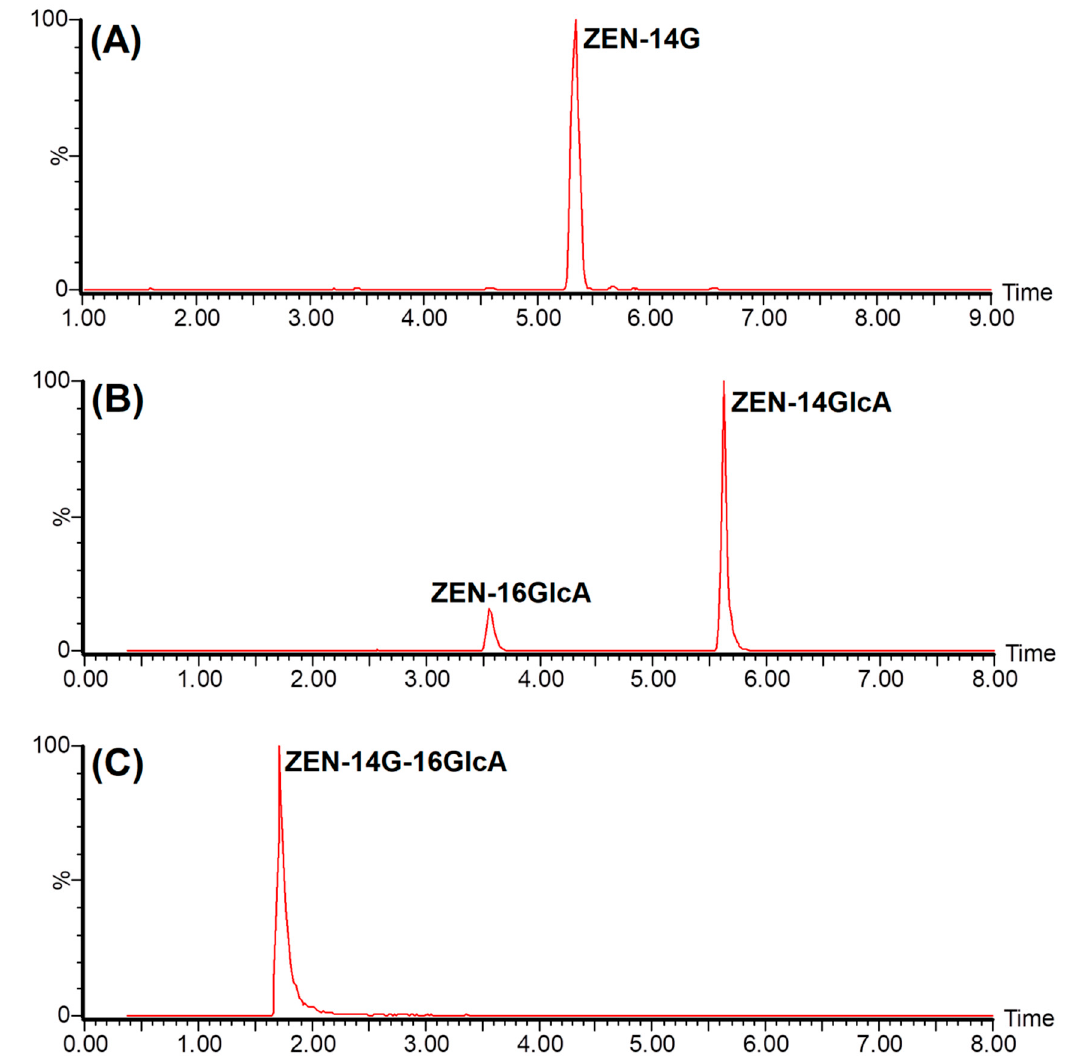
Figure 1. Representative extracted ion chromatograms (EICs, the extraction window was 50 mDa) of ZEN-14-glucoside (ZEN-14G, m / z 479.19227) ( A ) and its major phase II metabolites ZEN-14-glucuronic acid (ZEN-14GlcA, m / z 495.18719) ( B ) and ZEN-14G-16GlcA ( m / z 655.22436) ( C ) detected in rat plasma after intravenous injection (i.v.) and oral administration (p.o.).